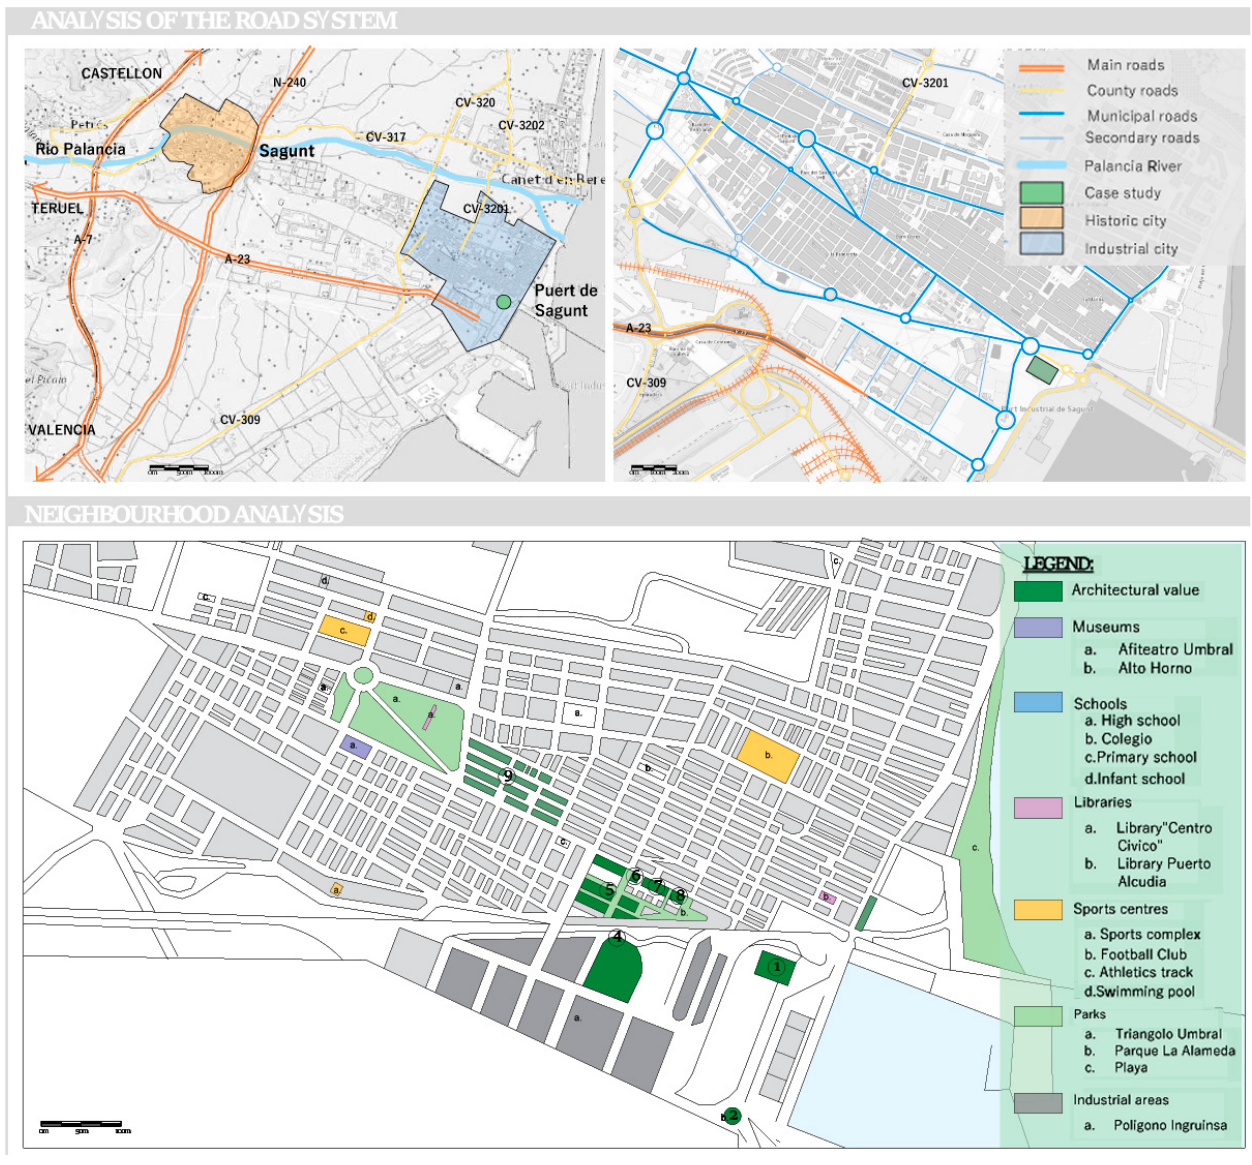
Figure 1. Analysis of the neighborhood and identi fi cation of compatible uses in the speci fi c territory.